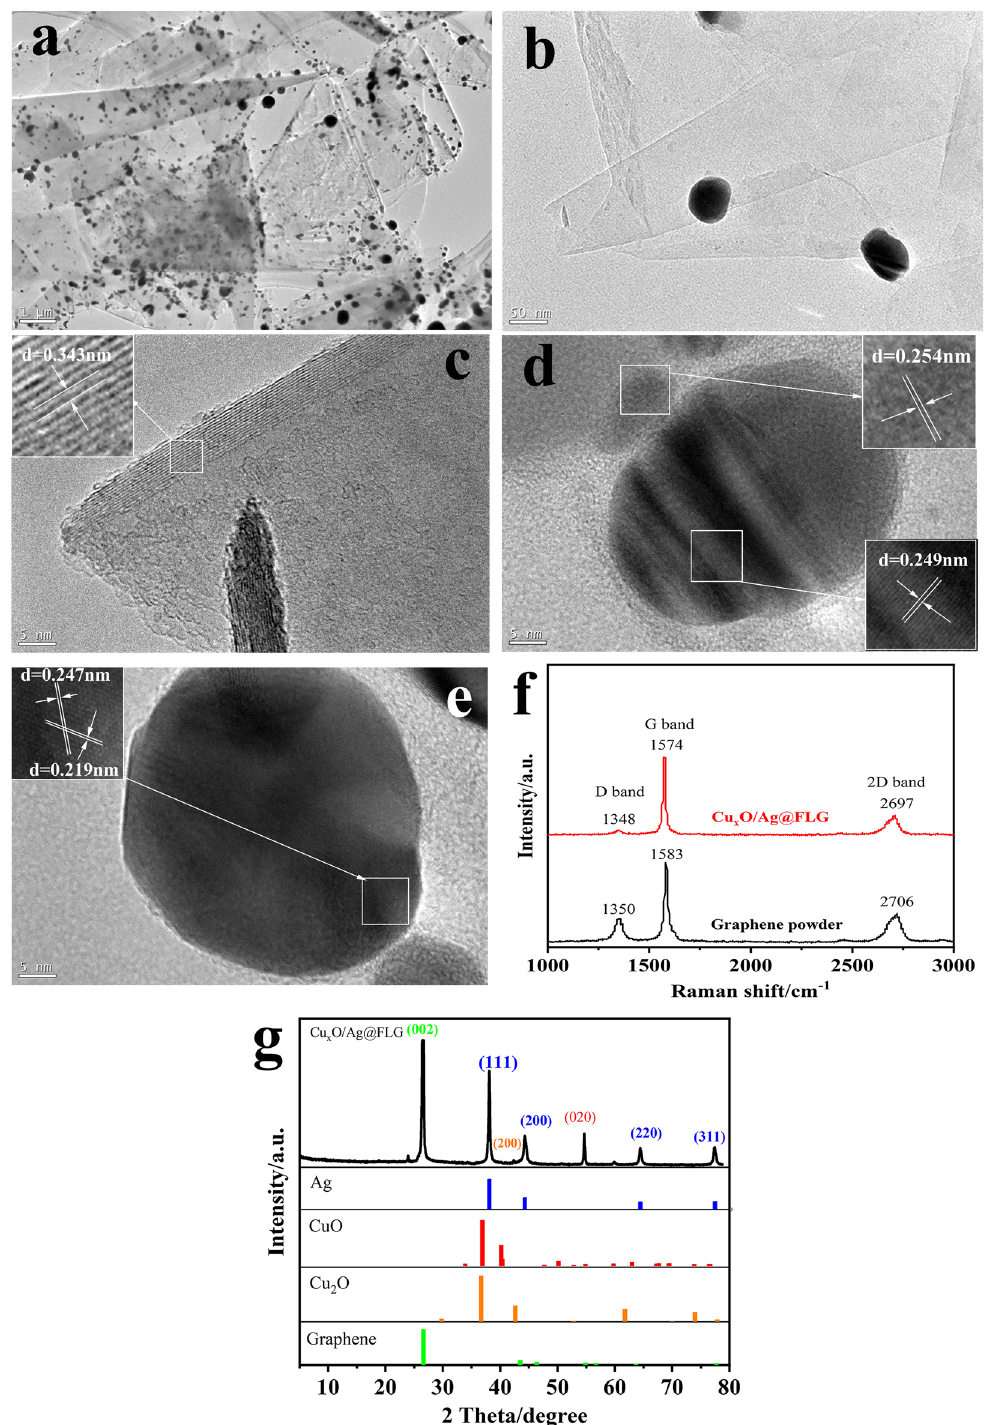
Figure 2. ( a , b ) TEM images, ( c – e ) high resolution TEM (HRTEM) images and ( f ) Raman spectra ( g ) XRD pattern of